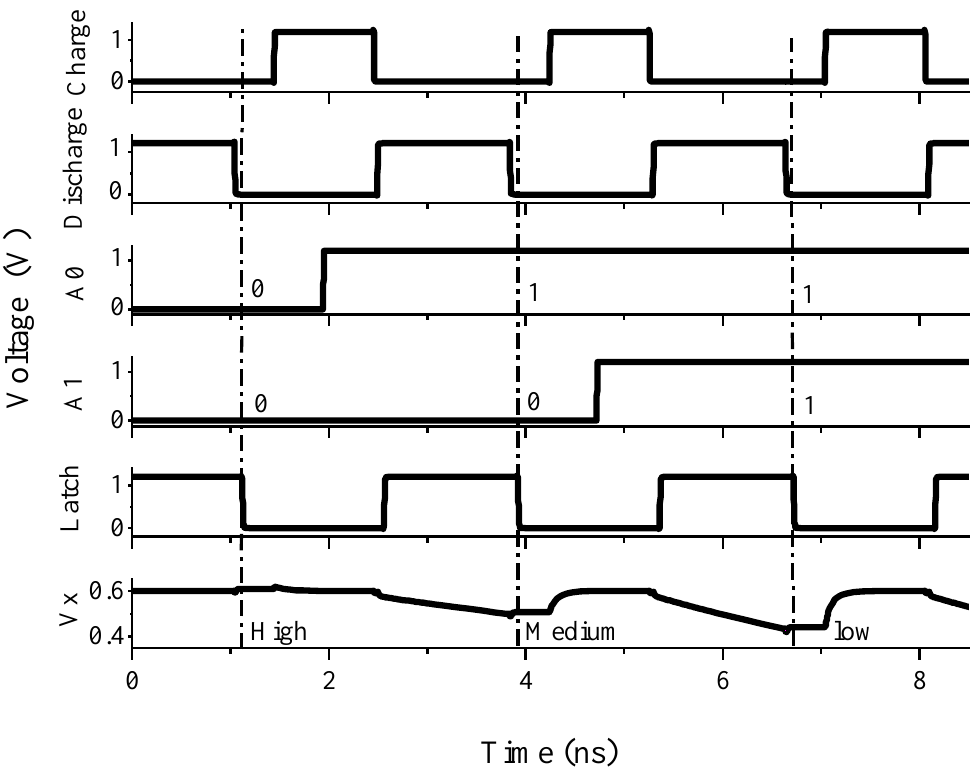
Figure 9. Transient simulation of current sensing circuit considering different combinations of data inputs A 0 and A 1.